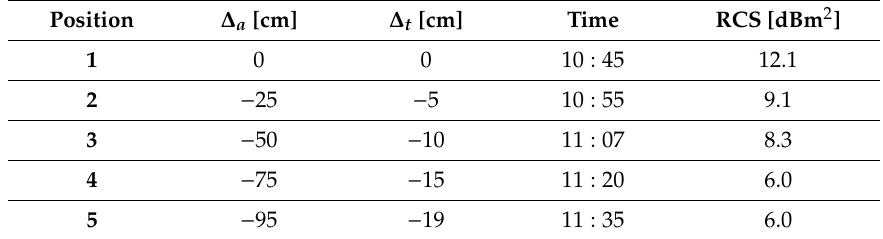
Table 2. Five positions during the trials on 16 May 2019. The last column shows the radar cross section (RCS) estimate for the medium corner reflector